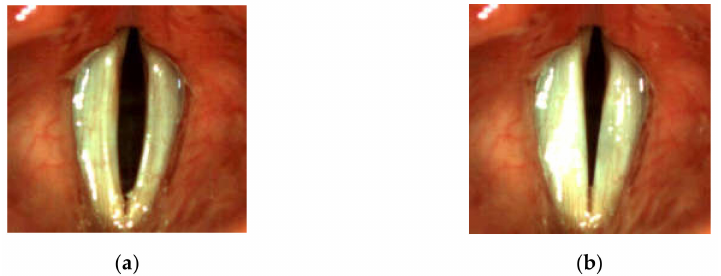
Figure 3. Images of the glottis for dysphonic patient D8 with severe glottal insufficiency for the maximum opening ( a ) and maximum closing ( b ) of the vocal folds correspondingly.